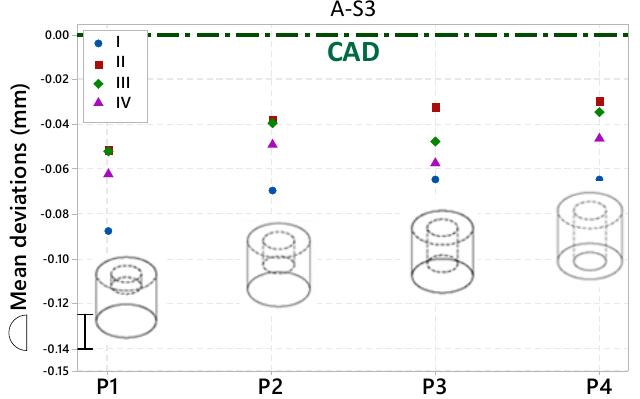
Figure 9. Three-dimensional (3D) profile mean deviations of the Shape A artifact having the biggest size S3 at each post-processing step; Scan I as-built; Scan II after stress relief; Scan III after part removal; and Scan IV after micro shot peening .